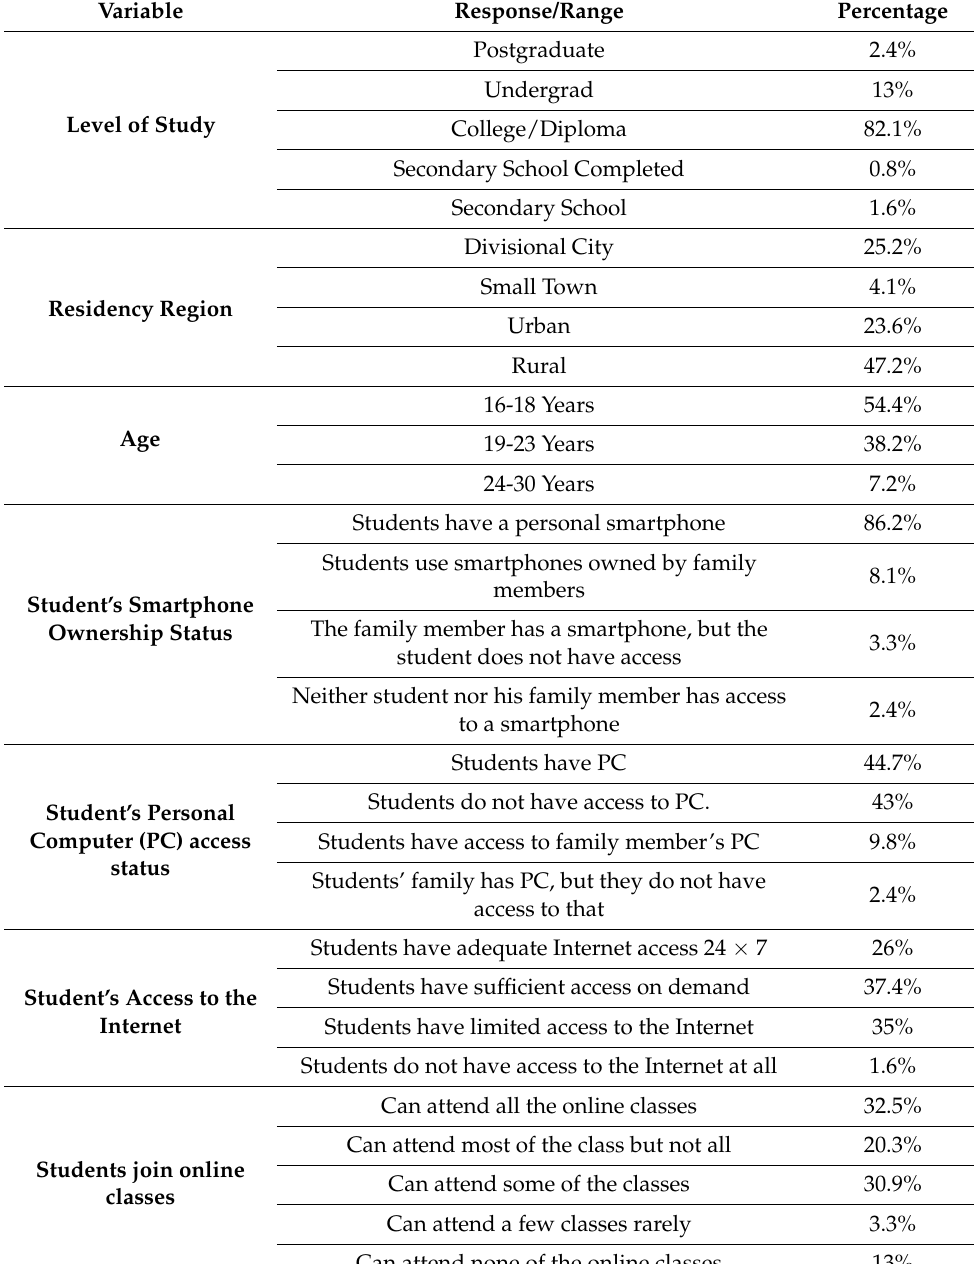
Table 1. Respondent student’s demography, ICT access, and e-learning activities overview (N = 123).